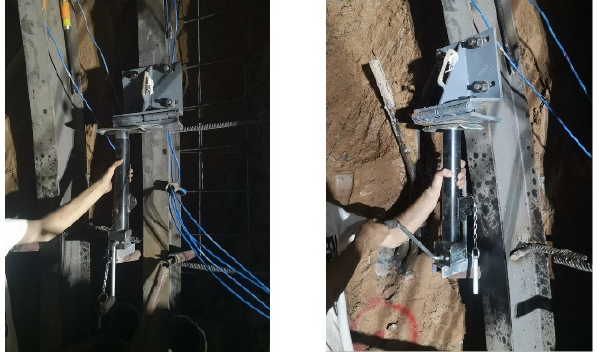
Figure 23. Site drawing of active loading of FSP on the upper bench of the first and second arches.